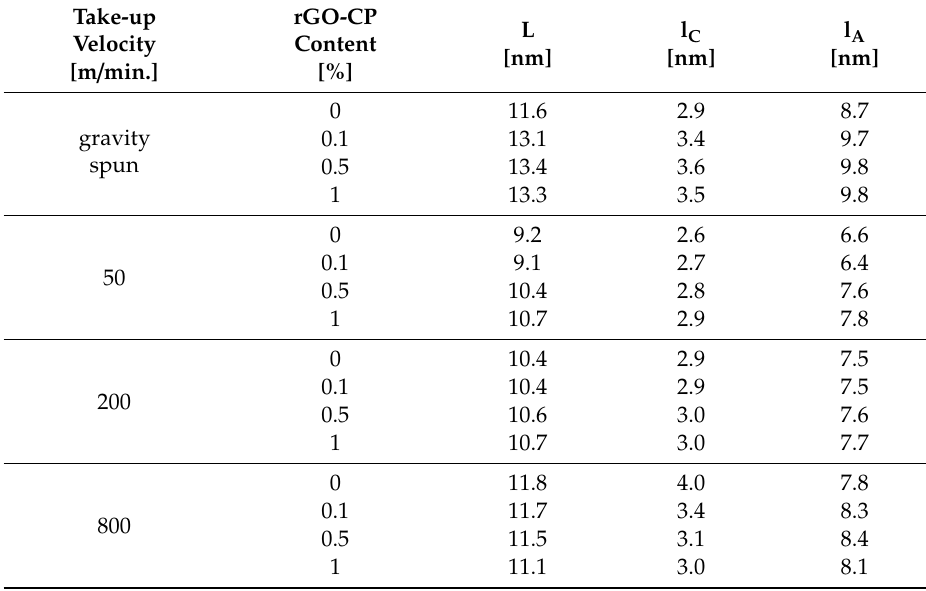
Table 7. Lamellar structure parameters of investigated fibers obtained by means of SAXS method. Take-up